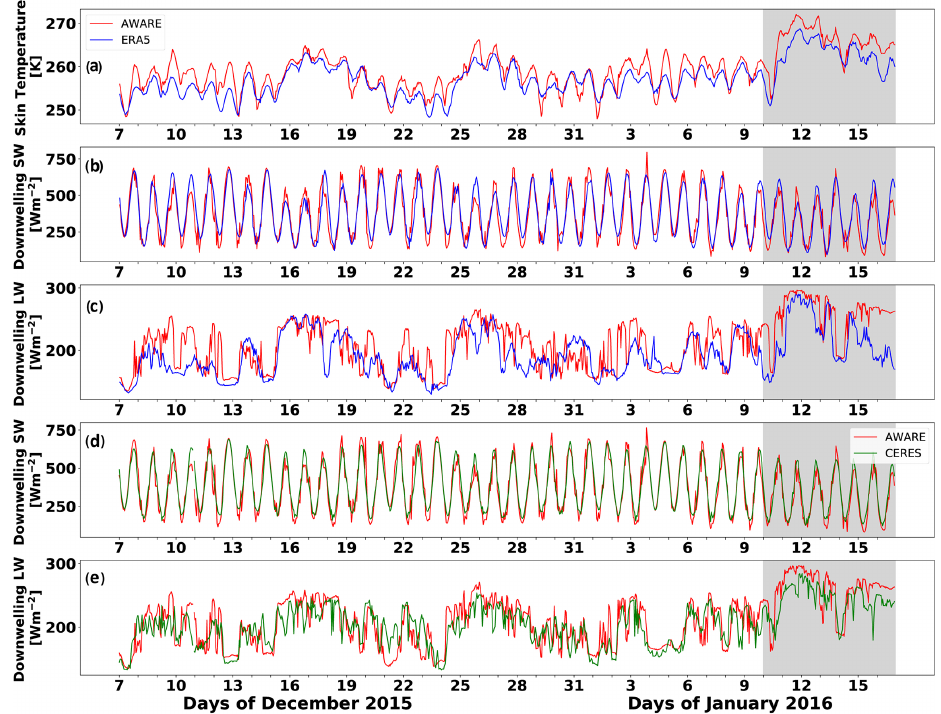
Figure A1. Time series comparison of hourly SEB components from ERA5 at the WAIS Divide ice camp with surface measurements from AWARE (Lubin et al. 2020; red curve in all plots): (a) skin temperature from ERA5; (b) downwelling SW flux from ERA5; (c) downwelling LW flux from ERA5; (d) downwelling SW flux from CERES SYN1deg; (e) downwelling LW flux from CERES SYN1deg. The shaded region indicates the WAIS January 2016 melt event period (Nicolas et al. 2017). One hour of surface radiometric data is missing on 10 December 2015, but the data are continuous